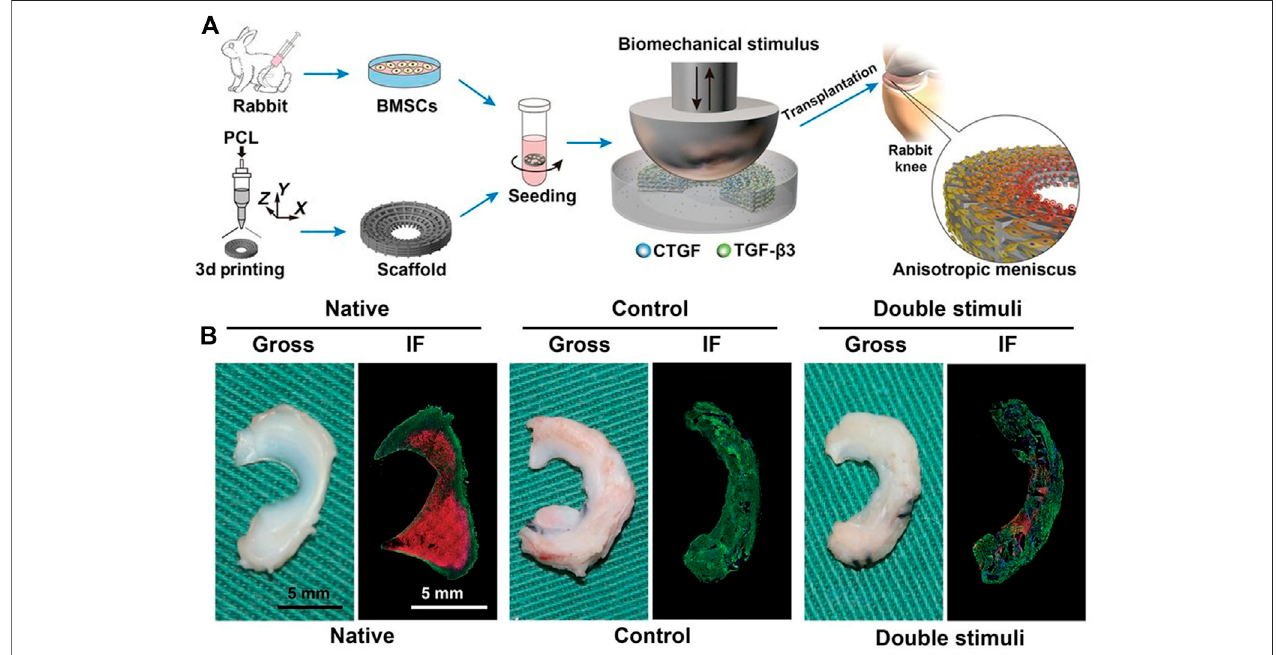
FIGURE 2 | Orchestrated biomechanical, structural, and biochemical stimuli for engineering anisotropic meniscus. (A) Schematic diagrams for reconstruction of functional anisotropic meniscus; (B) Gross view and low-magni fi cation immuno fl uorescence (IF) images of native or regenerated menisci at 24 weeks after in vivo implantation in rabbit knees. Green, COL-1; red, COL-2. Copyright 2019 American Association for the Advancement of